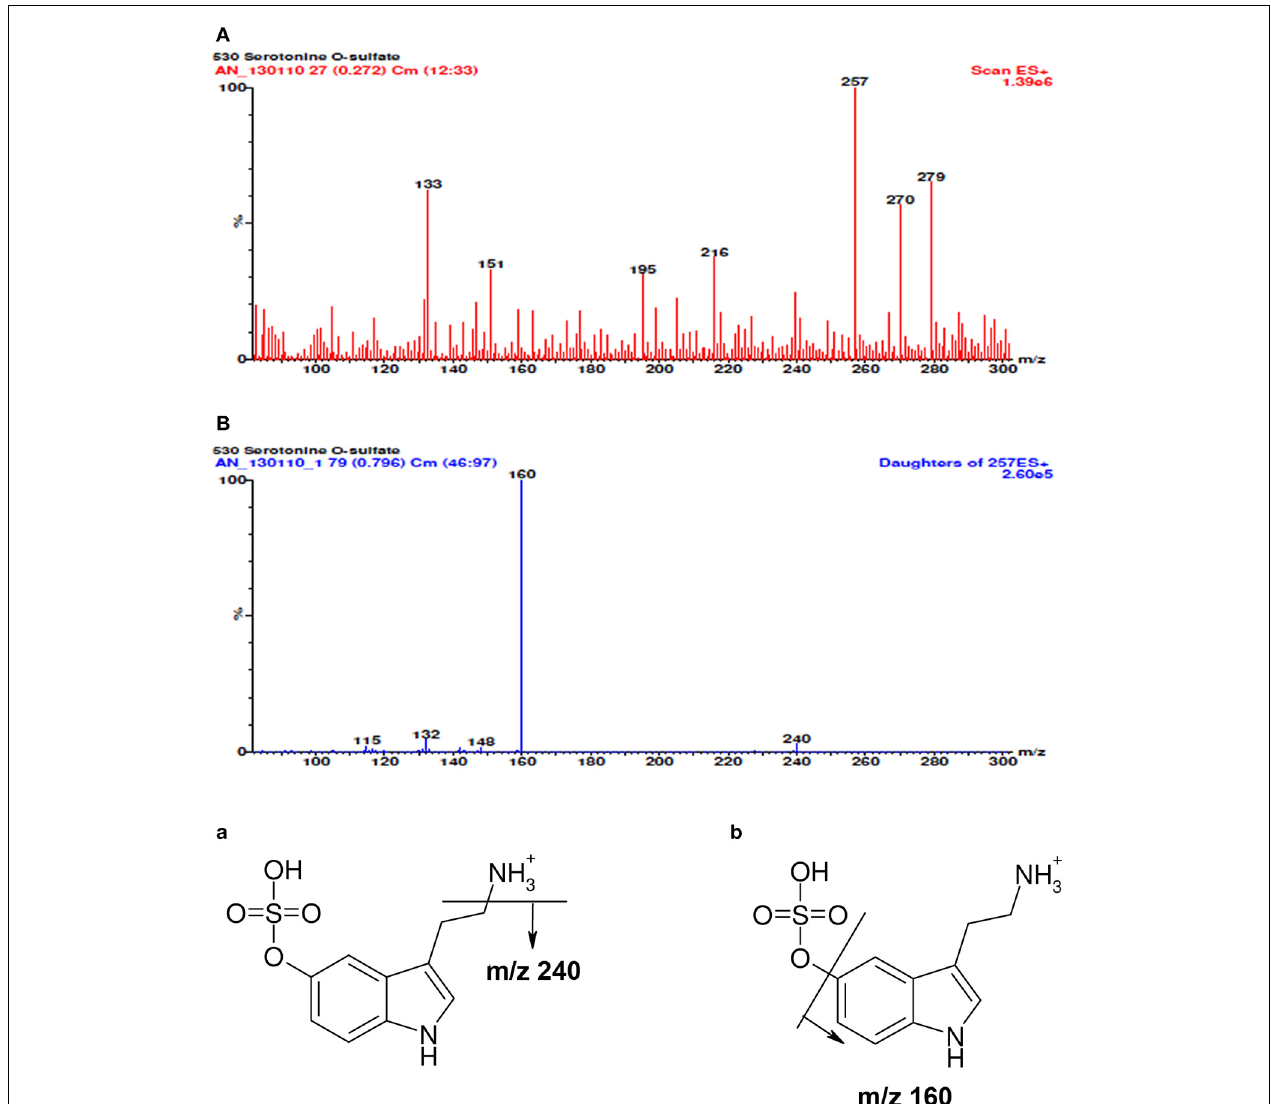
FIGURE 1 | The full mass spectra of 5-HT-SO4, daughter ions and possible scheme of fragmentation. In the spectra (A) besides molecular ion [M + H] + with m/z value of 257 a sodium adduct [M + Na] + (m/z 279) and some median intensity cleavage products (m/z- 240; 218; 195) are seen. The mass spectra (B) of molecular